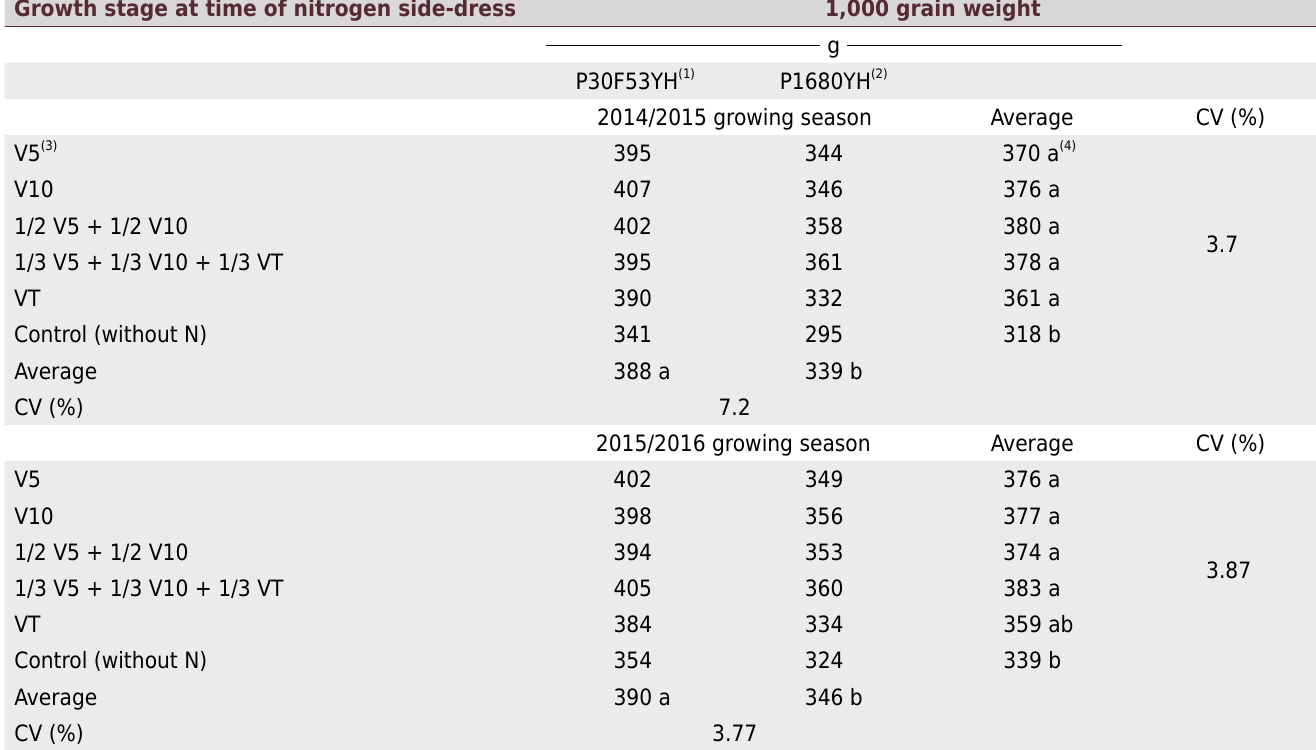
Table 5. A thousand grain weight of two corn hybrids as affected by the growth stage of plants at the time of nitrogen side-dress fertilization in Lages, Santa Catarina, Brazil Growth stage at time of nitrogen side-dress